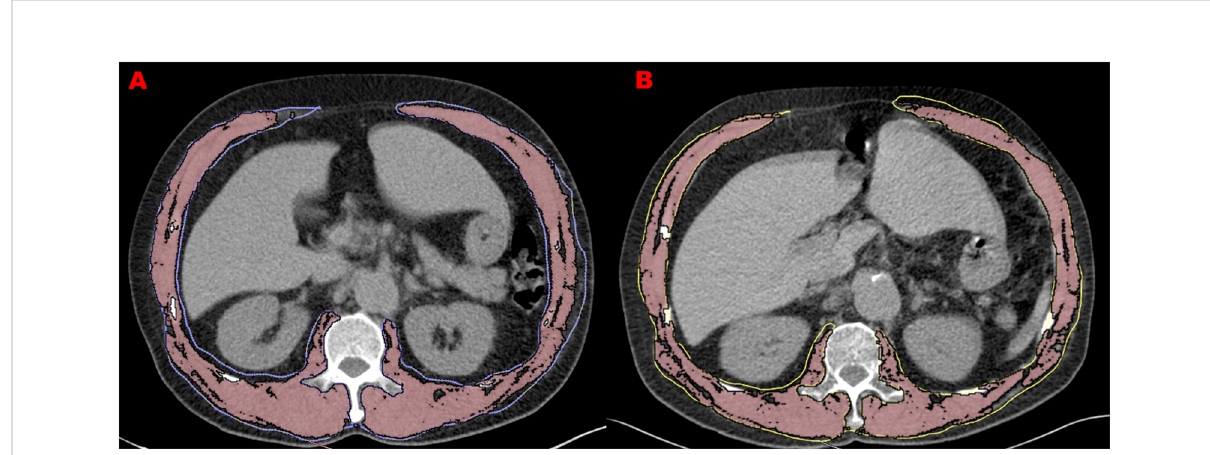
FIGURE 1 Muscle measurements at two screening chest CTs in 66-year-old man with COPD. (A) refers to L1 level CT image of 1 st CT scan with the measurement of trunk muscle density (31.9 HU) and size (140.7 cm 2 ). (B) refers to L1 level CT image of 2 nd CT scan performed 3 years after the initial one with the measurement of trunk muscle density (26.1 HU) and size (114.8 cm 2